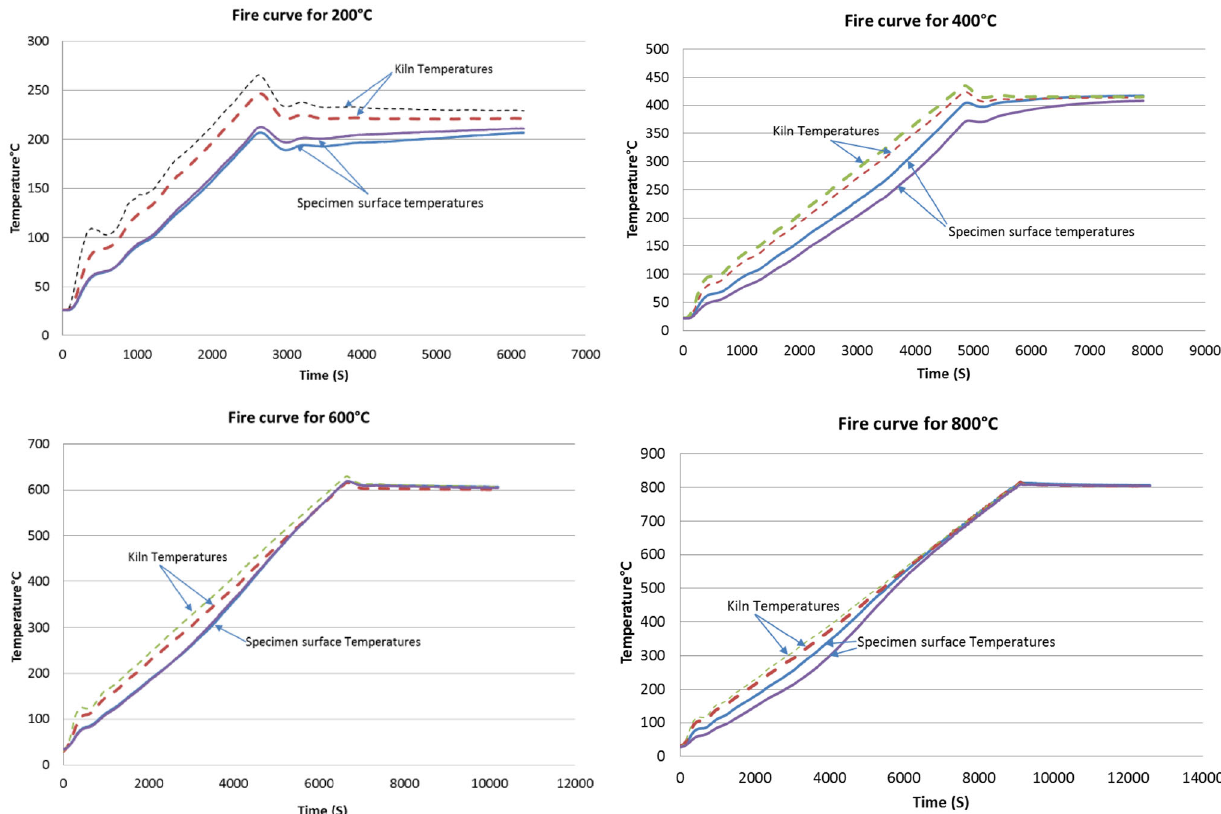
Fig. 2 Fire curves for different elevated temperatures in the kiln during